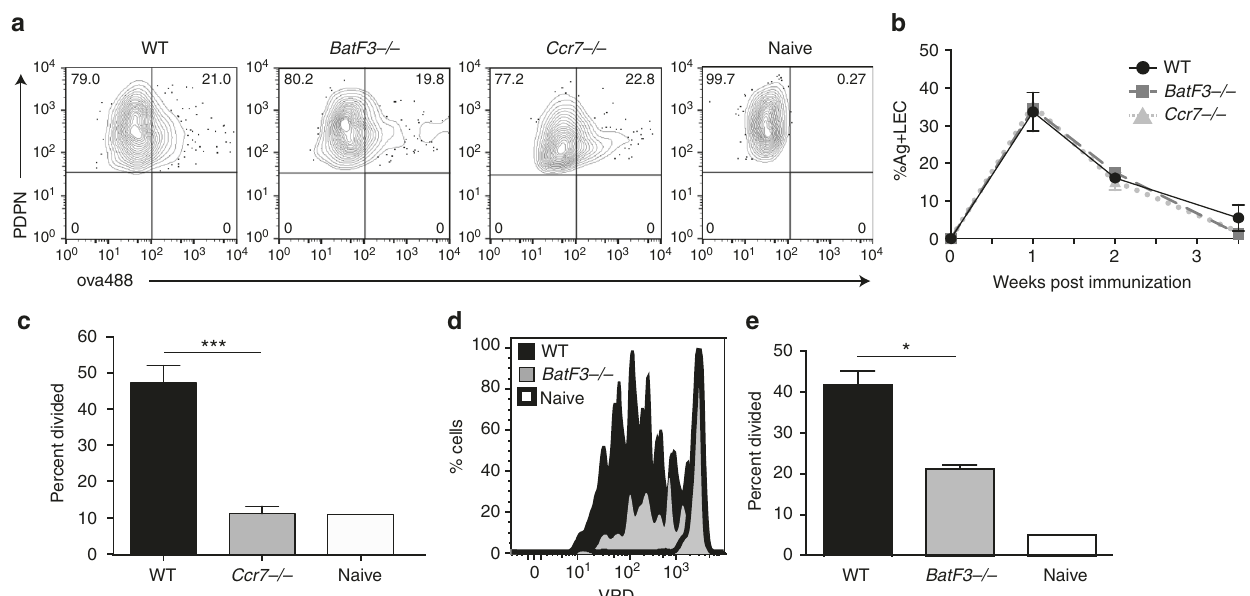
Fig. 3 Archived antigen presentation is dependent on Ccr7. a Mice were immunized with ovalbumin conjugated to Alexa fl uor 488 (ova488)/poly(I:C)/ α CD40 as in Fig. 1. Two weeks after immunization mice were killed, lymph nodes digested and stained for stromal markers. Shown are antigen-positive lymphatic endothelial cells from wild type, BatF3 − / − , Ccr7 − / − , and unimmunized (naive) mice. b Mice were immunized as in a and killed 1, 2, or 3.5 weeks post immunization to evaluate differences in percentage of antigen on lymphatic endothelial cells in different strains. There were no statistically different points between strains. c OT1 T cells were transferred into wild-type (black fi lled) or Ccr7 − / − (gray) mice immunized 2.5 weeks prior and the percent divided was calculated using three mice per group and repeated three independent times. Statistical analysis was done using an unpaired t -test where p = 0.0003 between wild-type and Ccr7 − / − mice. d Wild-type or BatF3 − / − mice were immunized 3 weeks prior to killing and OT1 division was evaluated by violet proliferation dye (VPD) dilution. e Quantitation of d . Representative experiments are shown in a and d , and quanti fi cation of four independent experiments with 3 – 5 mice per genotype is shown. Statistical analysis was done using an unpaired t -test, where p = 0.0016 in e . Error bars shown in the fi gure are mean and standard error of the